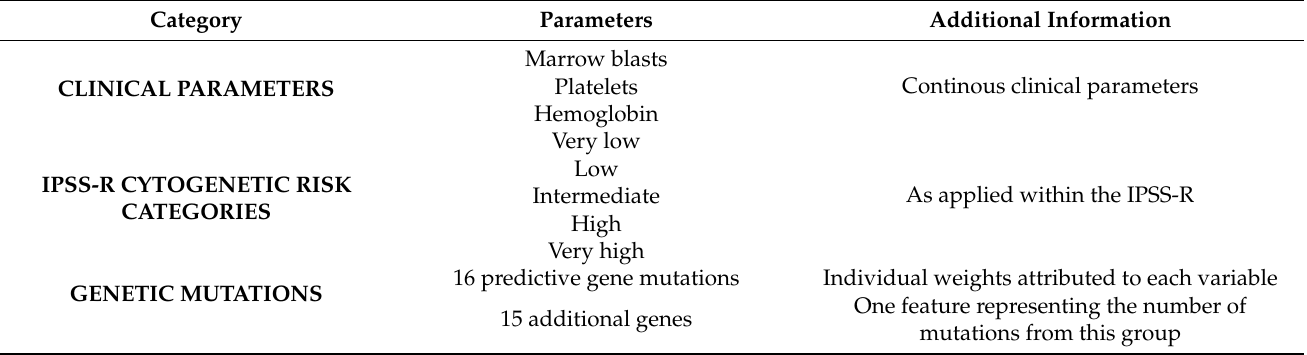
Table 2. The IPSS-M: major prognostic categories and its